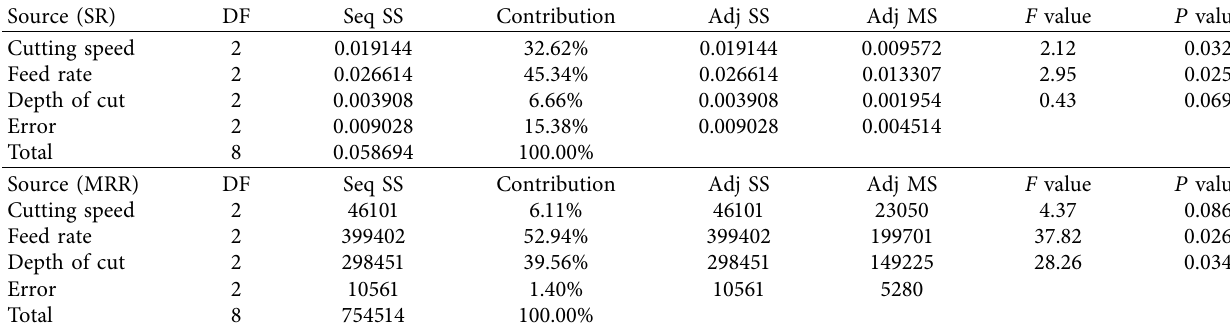
Figure 6: Surface plot of MRR at depth of cut with the variable levels of 0.1, 0.2, and 0.3mm, respectively. (a) Surface roughness versus feed rate. (b) Surface roughness versus depth of cut. (c) MRR versus cutting speed. (d) MRR versus depth of cut. (e) Surface roughness versus feed rate. (f) MRR versus depth of cut. Table 8: ANOVA results for SR and MRR